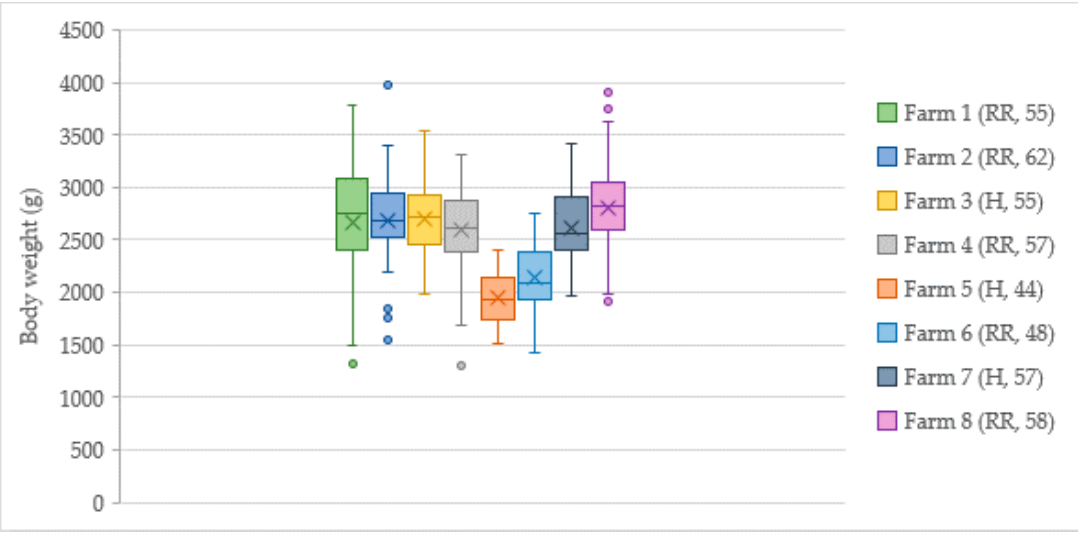
Figure 6. Distribution of chicken body weights in birds assessed ( n = 50) in flocks on Swedish organic farms ( n = 8). Hybrid (H: Hubbard; RR: Rowan Ranger) and age (days) within brackets.